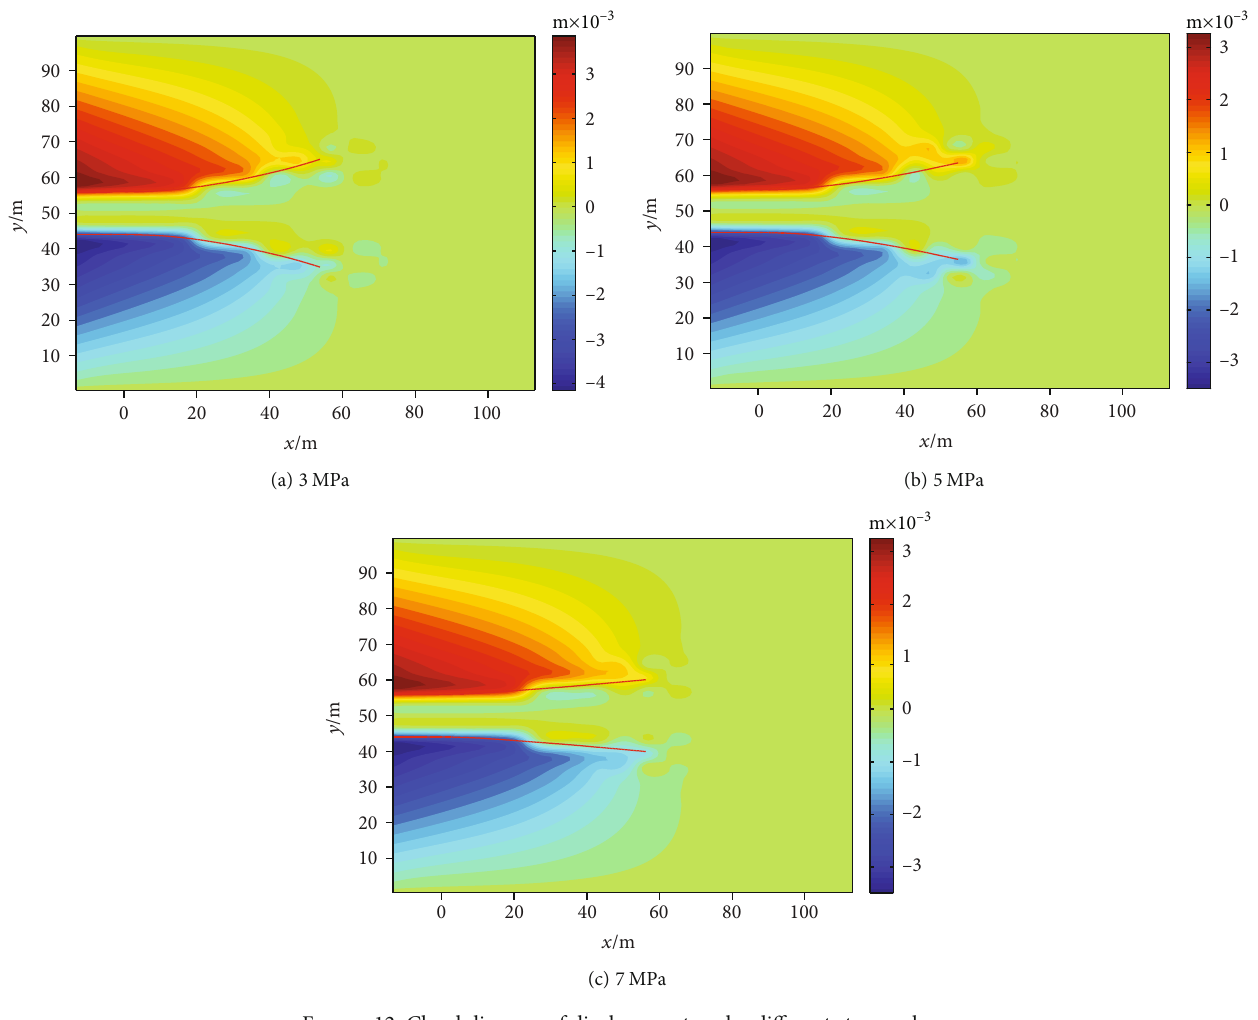
Figure 12: Cloud diagram of displacement under di ff erent stress